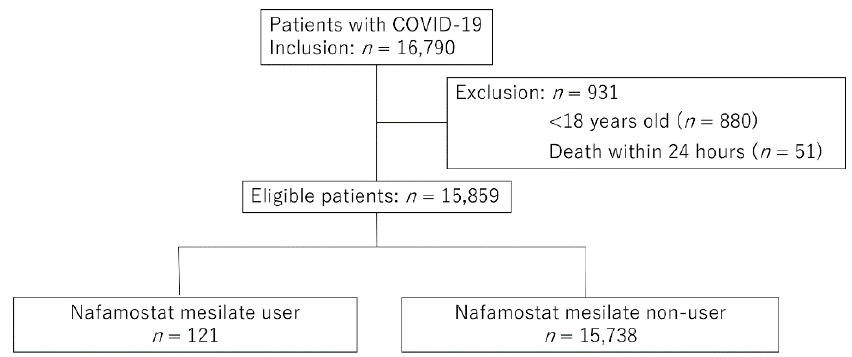
Figure 1. Flow chart of the patient selection process. COVID-19, coronavirus disease 2019.